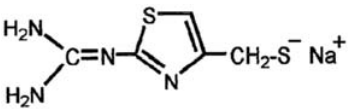
Figure 2c: Famotidine base degradate (Brown shiny